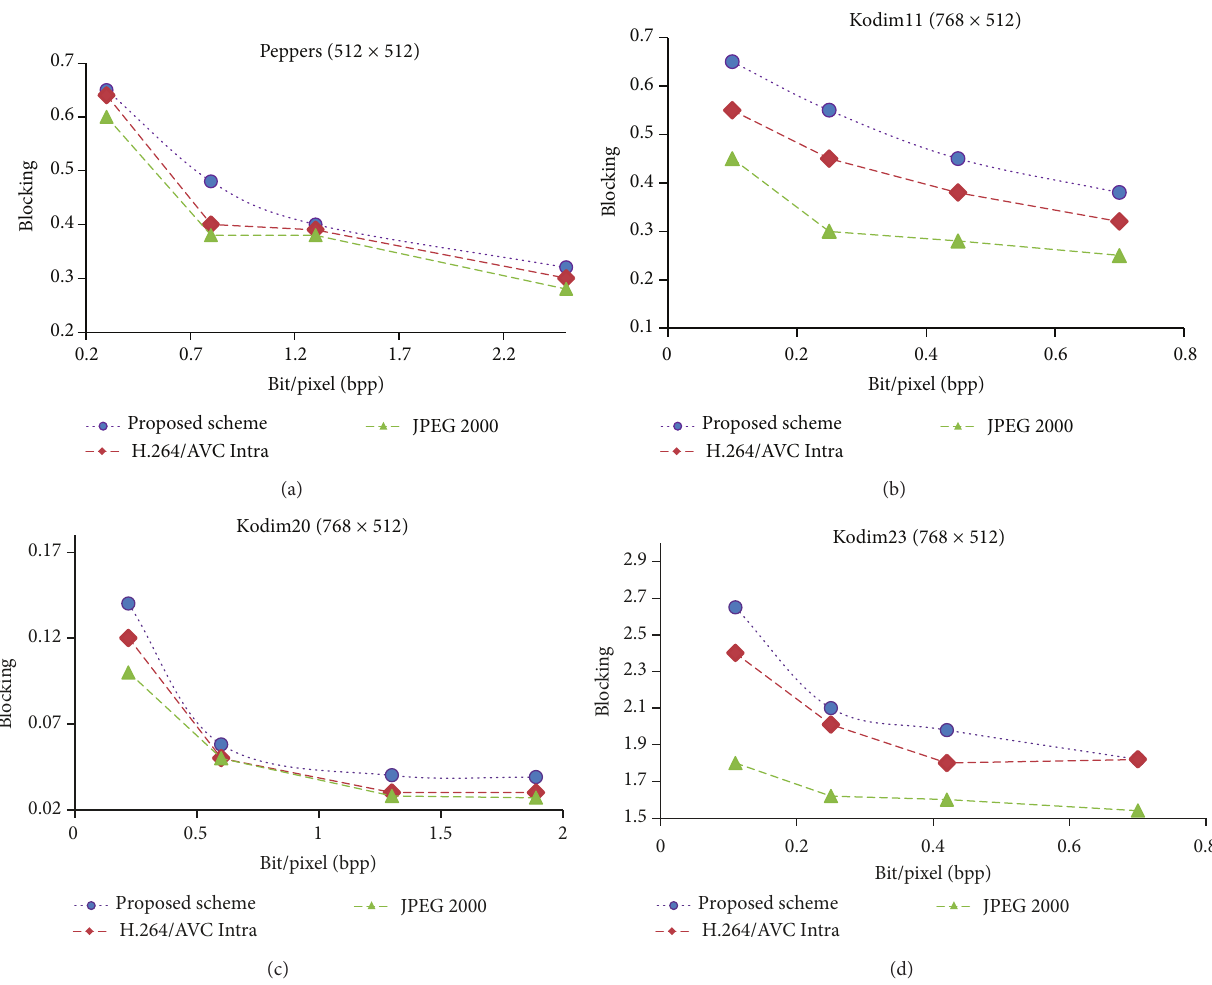
Figure 11: Quality assessment (by measuring the blocking artifacts by the method in [26]) results that compare the proposed scheme with JPEG 2000 and H.264/AVC Intra on some typical color